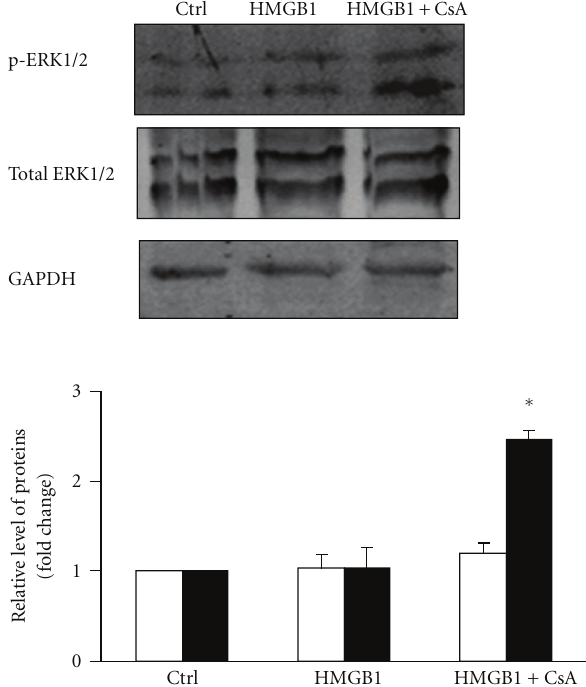
Figure 5: E ff ect of 200 ng/mL HMGB1 on ERK1/2 phosphorylation in NRVMs. NRVMs were pre-incubated with CsA for 1h, and then incubated with 200 ng/mL HMGB1 for 2h. ERK1/2 phos- phorylation in NRVMs was determined by Western blot analysis. The graph shows fold changes in phosphorylated ERK1/2 ( (cid:2) ) and total ERK1/2 ( (cid:3) ). The bar graph represents three independent experiments. ∗ P < 0 . 05 versus 200 ng/mL HMGB1 treated